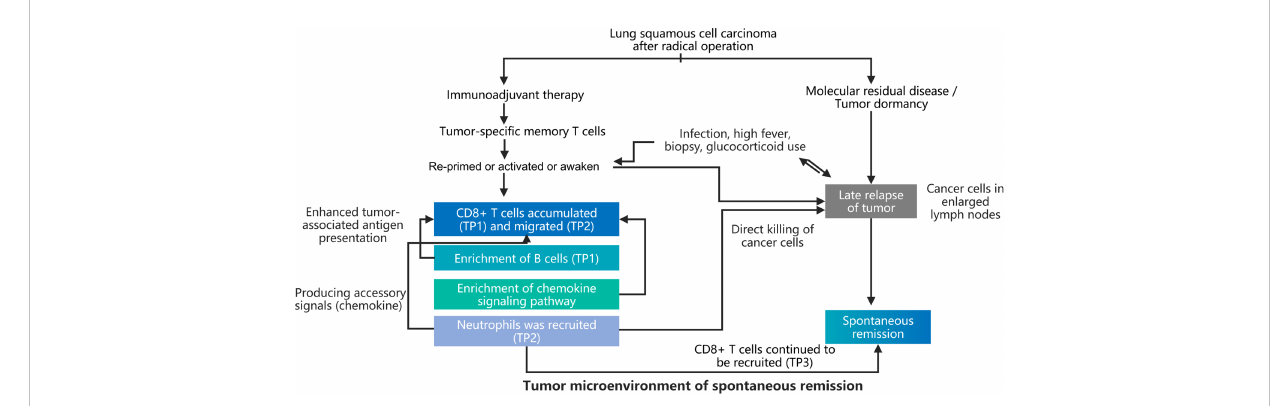
FIGURE 3 Diagram illustrating the potential mechanisms underlying the spontaneous